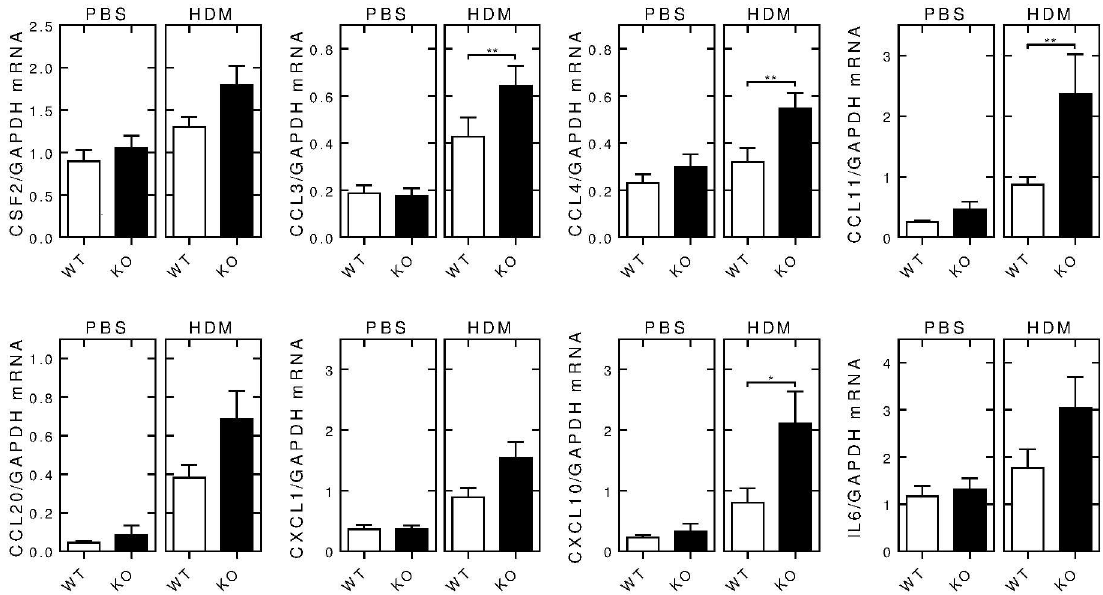
Fig 7. Effect of RGS2 deficiency on inflammatory mRNA expression in PBS- and HDM-exposed animals. Wild type (WT) and Rgs2 -/- (KO) mice were subjectedto intranasal exposureto PBS (left panels) or HDM (25 μ g) (right panels)3 times/week for 3 weeks. RNA was extracted from the right lungs and mRNA analyzedby qPCR. Data ( N = 23 for PBS-exposedwild type and 22 for Rgs2 -/- , N = 34 for HDM-exposed wild type and 29 for Rgs2 -/- ), normalized to GAPDH mRNA, are plotted as means ± SE. Significance was tested betweenwild type and Rgs2 -/- groups by Mann Whitney U test. * P < 0.05 and ** P <